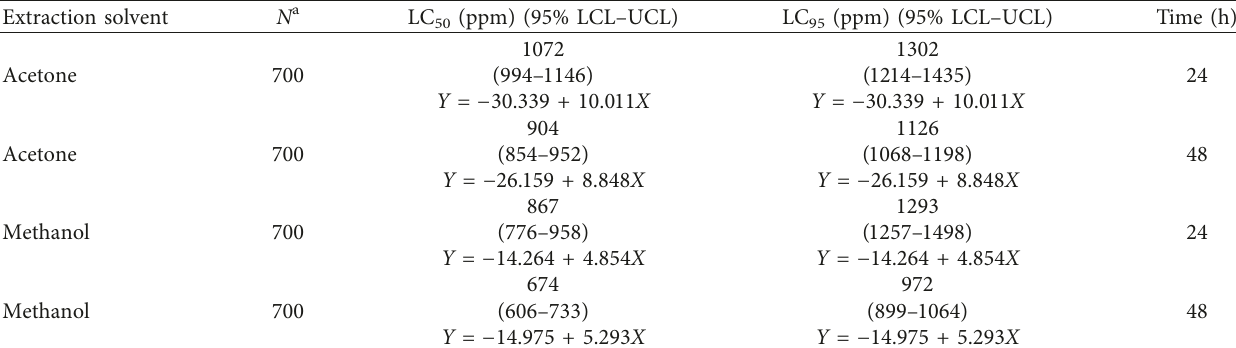
Table 1: Larvicidal activity of Azolla pinnata extracts against late 3rd instar larvae of Aedes